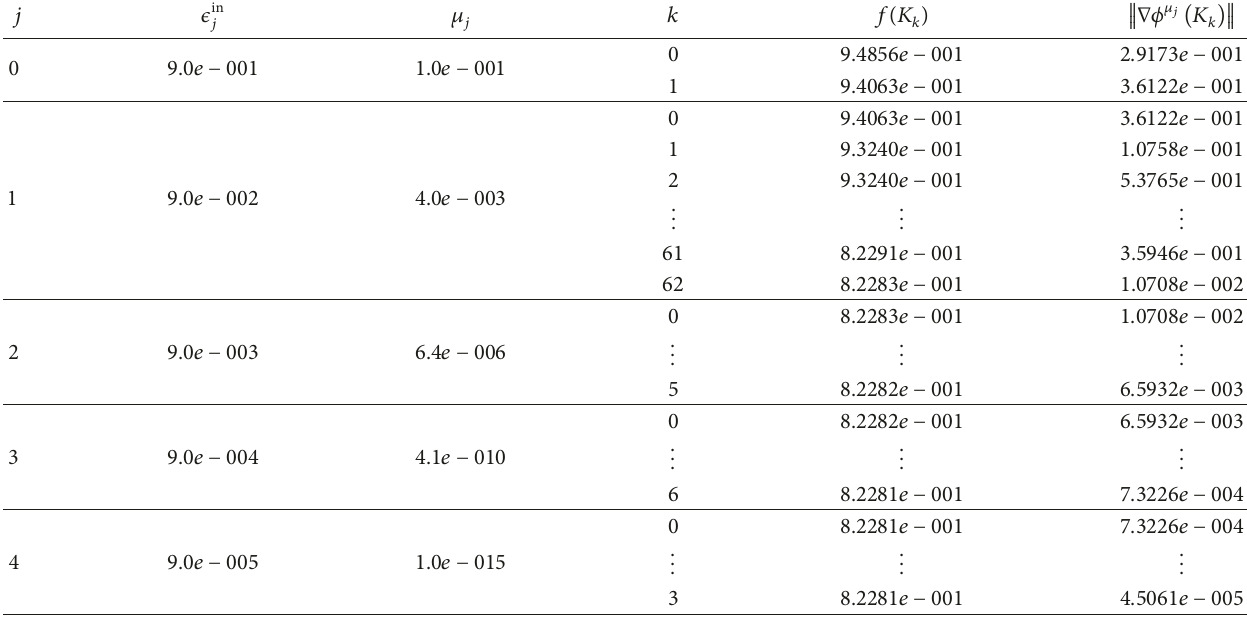
Table 2: Convergence behavior of the log–barrier interior–point method to a local solution for Example